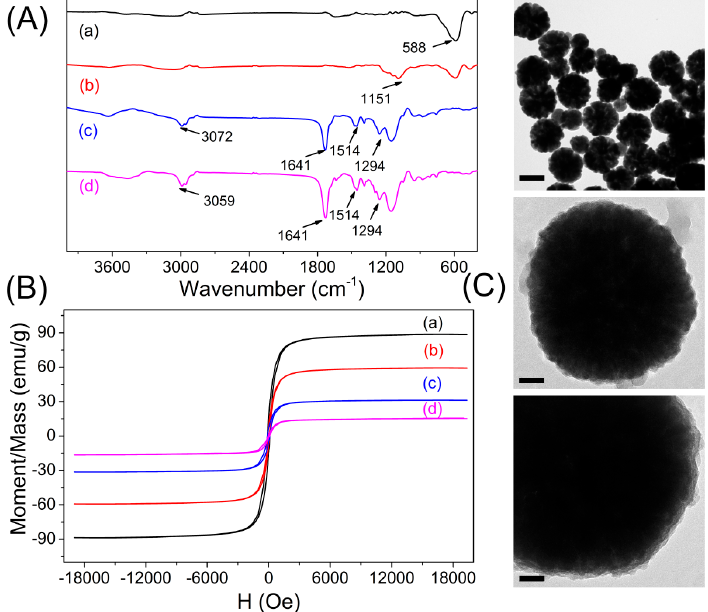
Figure 2. ( A ) Fourier transform infrared spectrometer analysis of: Fe 3 O 4 (a); Fe 3 O 4 @SiO 2 (b); Fe 3 O 4 @MIPs (molecularly imprinted polymers) (c); and Fe 3 O 4 @NIPs (non-imprinted polymers) (d). ( B ) Magnetization curves of: Fe 3 O 4 (a); Fe 3 O 4 @SiO 2 (b); vinyl-modified Fe 3 O 4 (c); and Fe 3 O 4 @MIPs (d). ( C ) Typical high-resolution transmission electron microscopy (HRTEM) photographs of the Fe 3 O 4 (top, scale bars = 300 nm), and Fe 3 O 4 @SiO 2 (middle and bottom, scale bars = 50 nm). H: magnetic field.